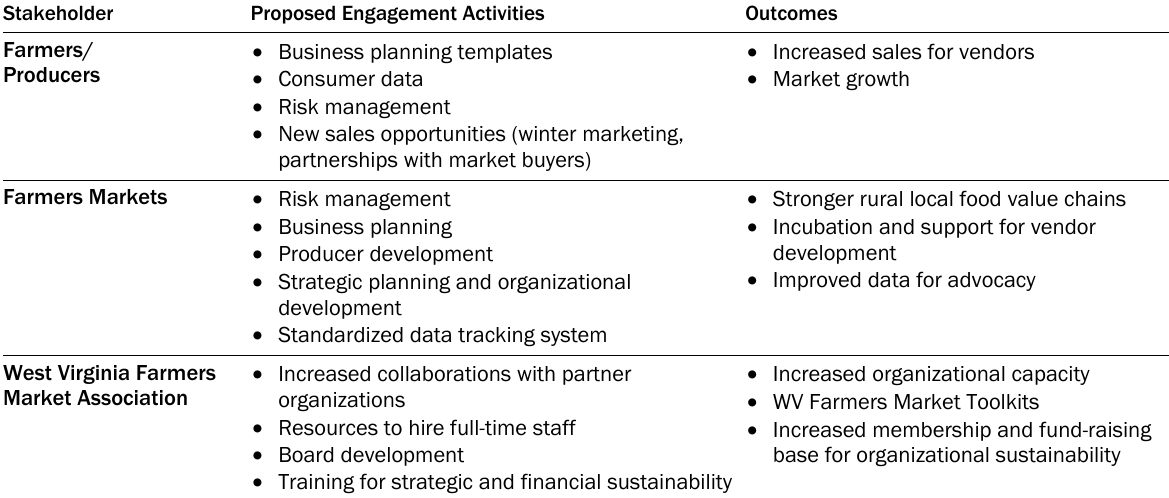
Table 1. Stakeholder Engagement in FMTNPP Activities and Expected